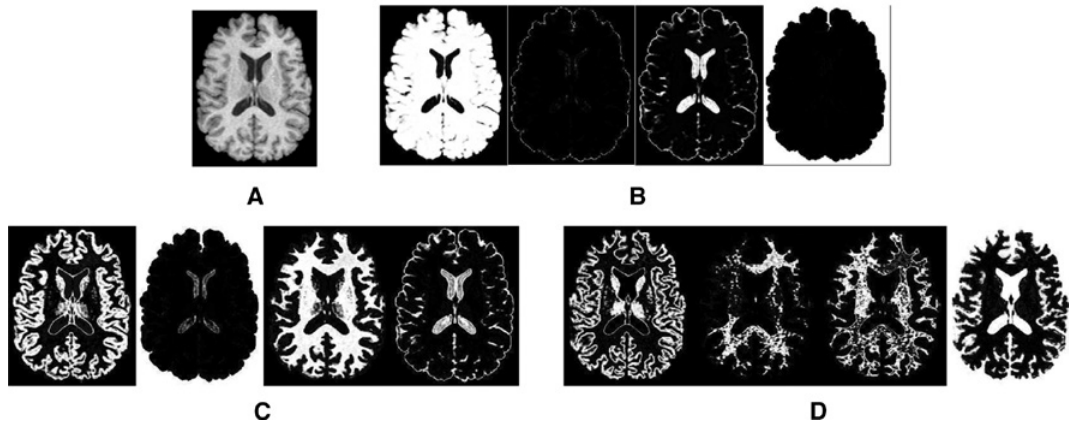
Figure 1: Segmentation Result of Alg1 With Different λ Values on Brain Image With Cluster Number = 4 (A) Input Image (B) λ = 0.5, (C) λ = 1, (D) λ =